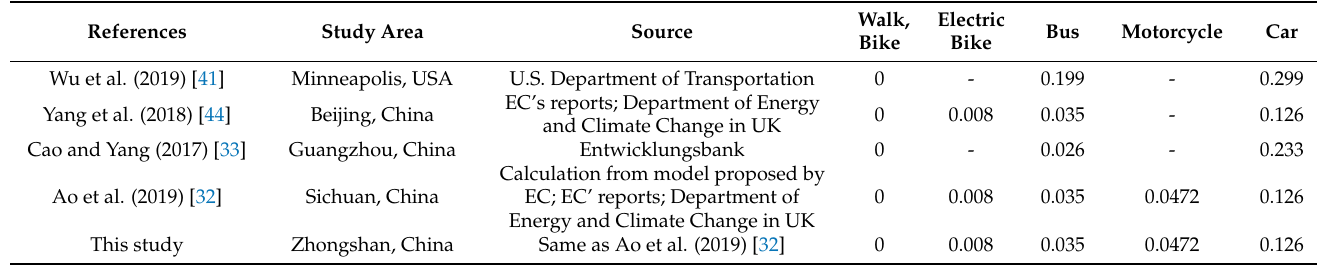
Table 1. Carbon emission factors for different travel modes (kg/person